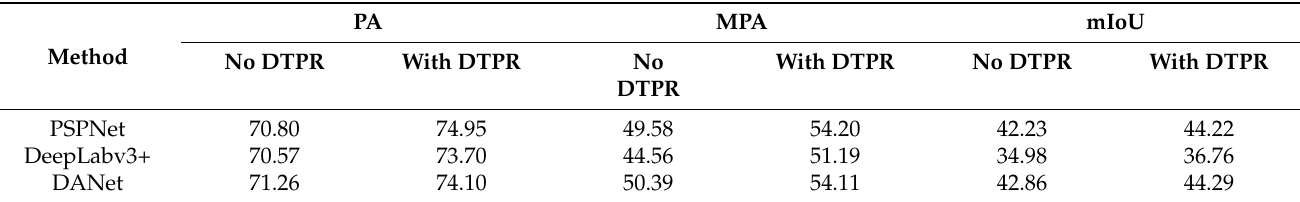
Table 5. Comparison of the SOTA model on the LIP validation set.